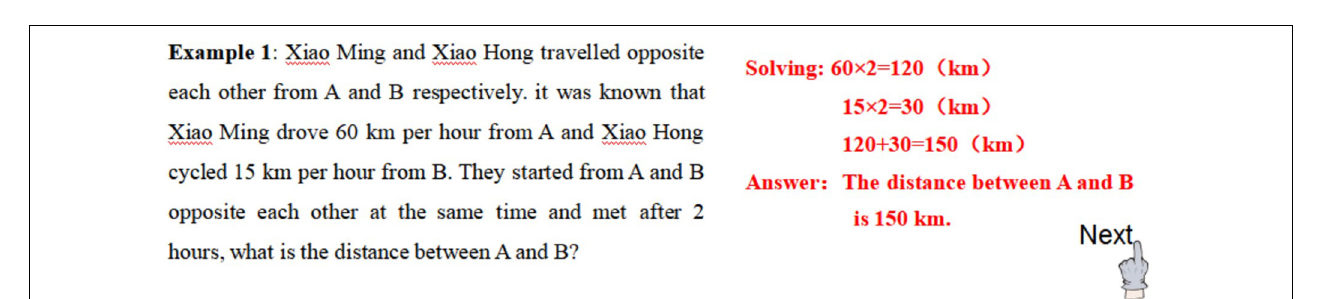
FIGURE 2 | Subgoal-worked example.